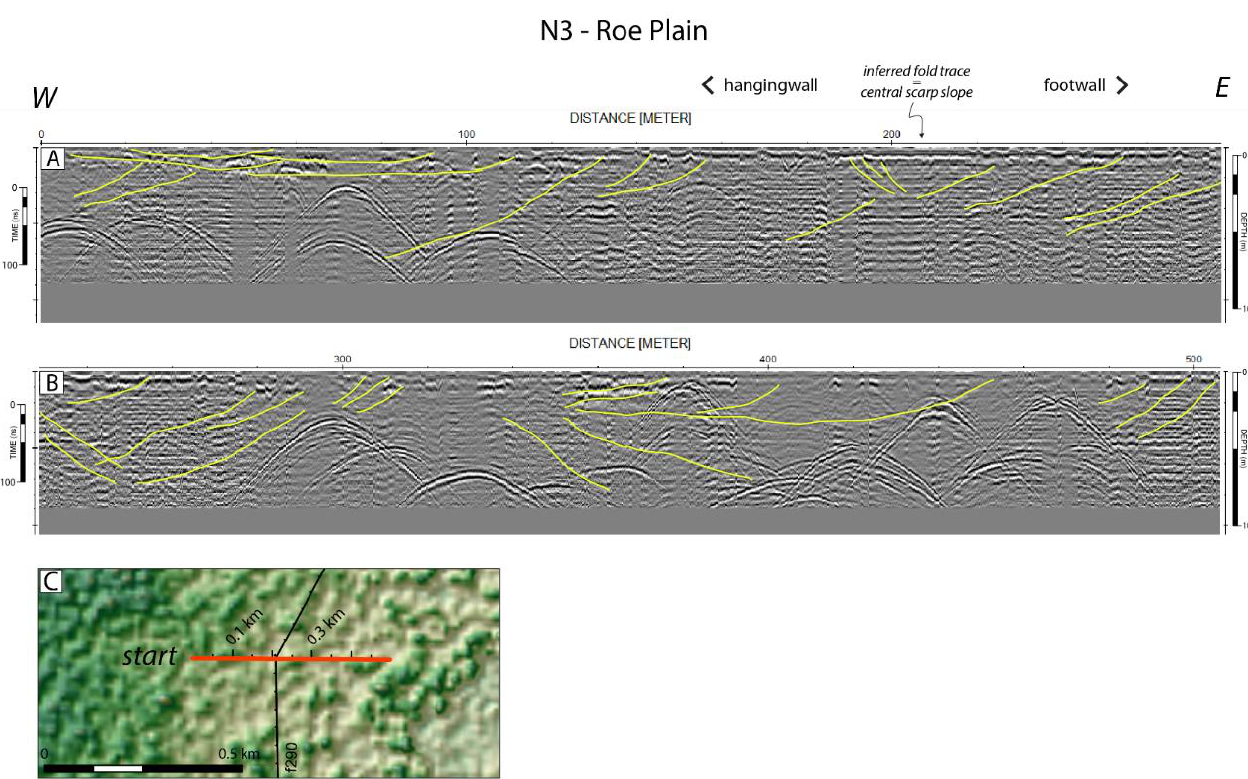
Figure 7. ( A , B ) GPR transect N3. Interpreted reflectors within the Abrakurrie Limestones are shown in yellow. Numerous hyperbolas image airwave reflections from trees, a fibre optic trench, wombat burrows and other cavities; ( C ) Local DEM showing the location of the transect and the inferred fault line in relation to one another. The vegetation cover is imaged by the ‘knobbly’ surface. Several strong but discontinuous surface reflectors correlate roughly with reported thicknesses of the Roe Calcarenite (upper 1 – 3 m, Australian Stratigraphic Units Database, last accessed: 10 July 2022). The Roe Plain is eroded into the Abrakurrie Limestone which is likely to be represented by the main body of the GPR data below the stronger surface reflectors. Several inclined, often curvilinear reflectors (yellow solid lines) have been iden- tified within the limestone, possibly imaging sedimentary strata. Although the density of interpreted reflectors does not allow a detailed picture of the limestone strata structure, varying dipping directions of interpreted reflectors imply localised erosion surfaces and channelization during deposition.